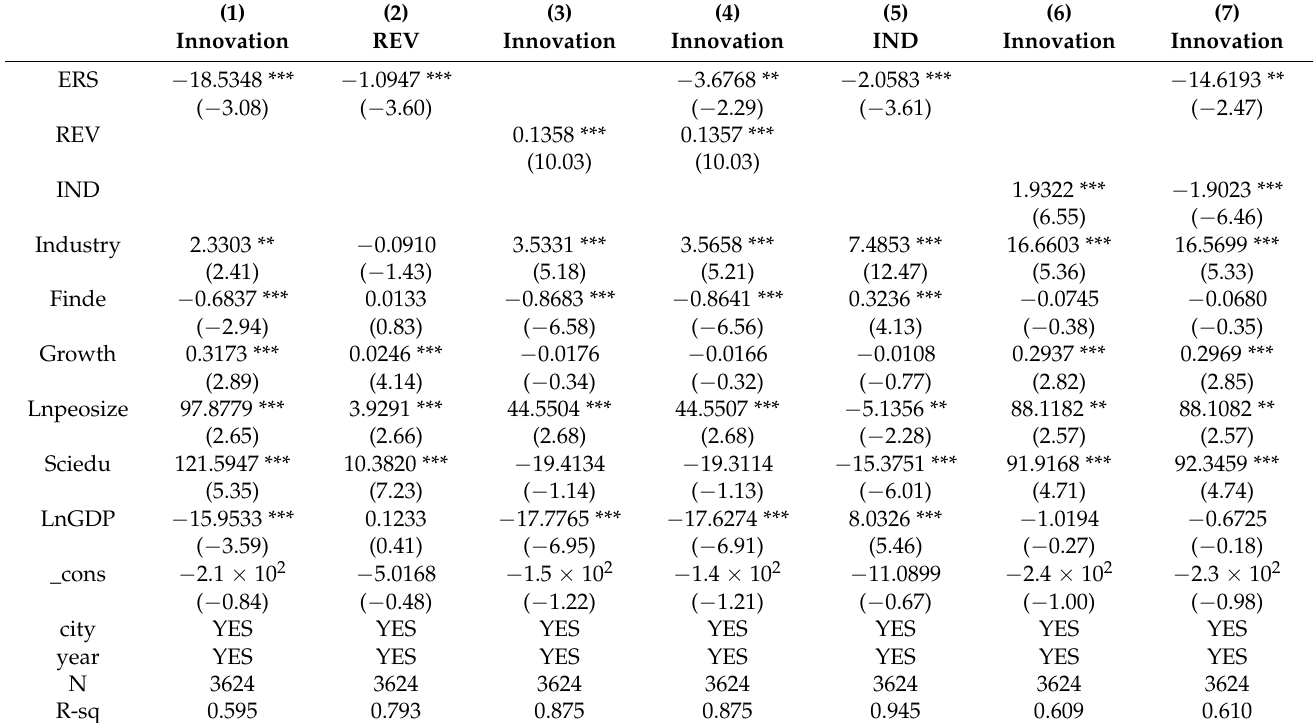
Table 12. Mechanisms by which environmental regulation affects the innovation capacity of Chinese